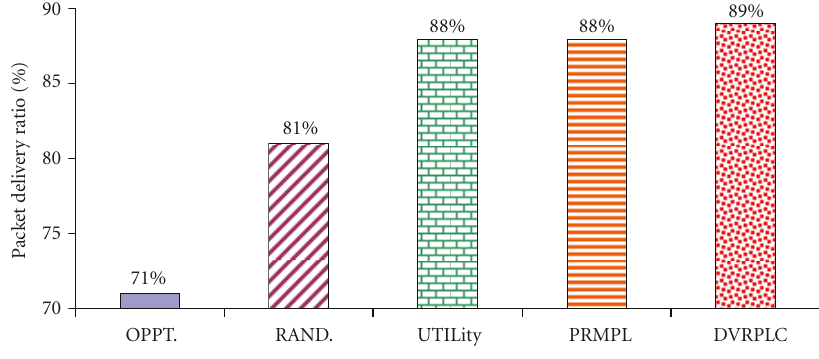
Figure 11: Packet delivery performance observed for di ff erent protocols.